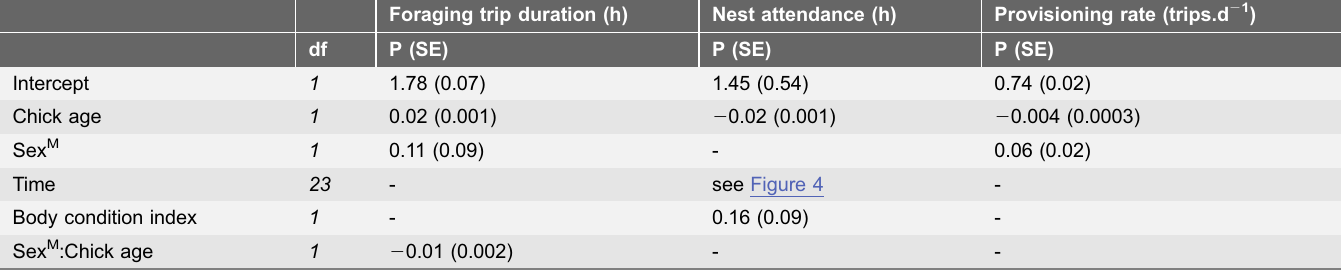
Table 2. Most-parsimonious linear mixed-effects models of Cape gannet behavioural parameters fitted by restricted maximum likelihood.